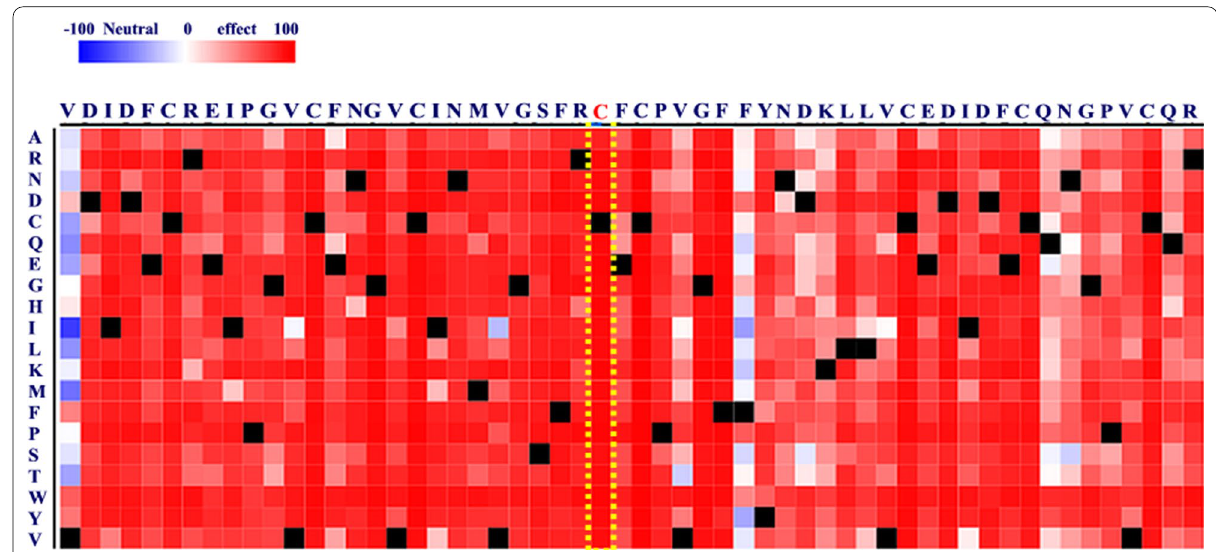
Fig. 2 SNAP2 heatmap of FBN1 gene prediction scores. The predicted effect of each variant from the wild-type amino acid ( x -axis) to any other amino acid ( y -axis) The color red denotes a strong signal for effect, the color white denotes a weak signal (inconclusive prediction), and the color blue denotes a strong signal for neutral variants. All amino acid substitutions with a score of 88 or higher were highlighted in red in position 1971 (highlighted in yellow box)